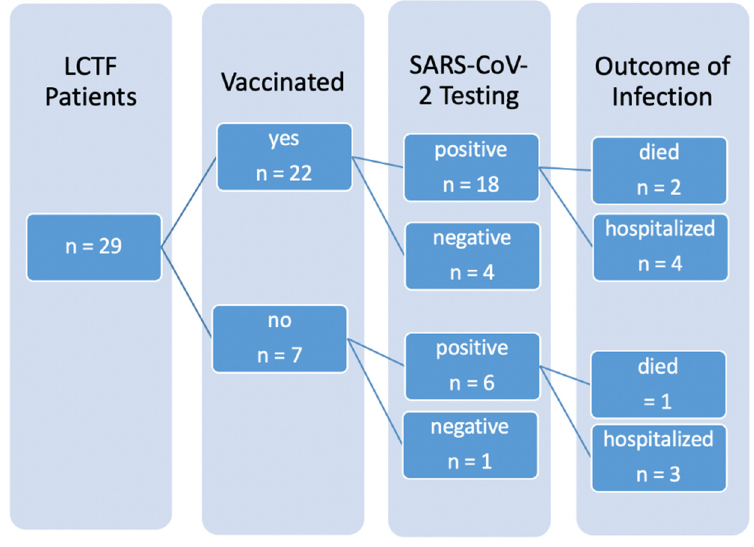
Figure 1. Patient flowchart.